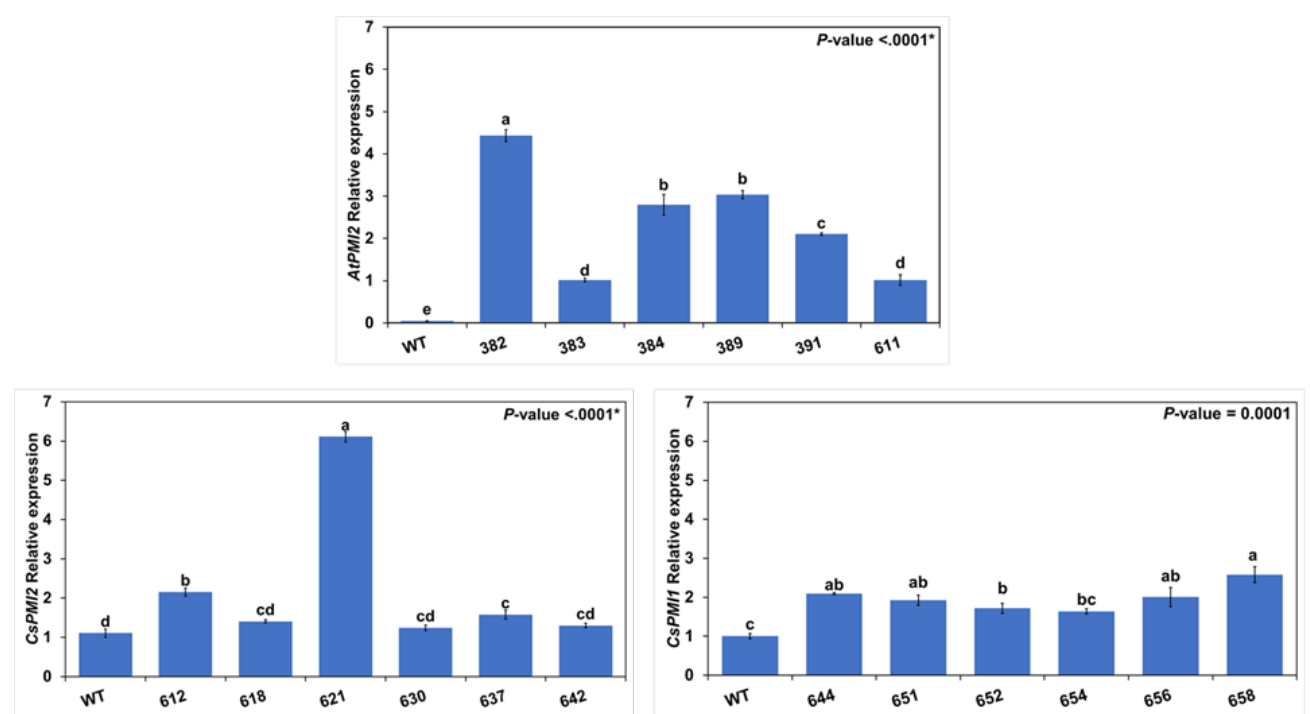
Figure 4. Quantitative real-time RT-PCR analysis of phosphomannose isomerase gene ( PMI) expression in citrus leaves. The citrus actin7 gene (NCBI accession: XM_006464503.3) was used as a reference gene for the normalization. WT, non-transgenic mature Kuharske. Upper: lines 382, 383, 384, 389, 391, 611 are the AtPMI2 transgenic lines. Lower left: lines 612, 618, 621, 630, 637, 642 are the CsPMI2 transgenic lines. Lower right: lines 644, 651, 652, 654, 656, 658 are the CsPMI1 transgenic lines; six independent transgenic lines of mature Kuharske were selected randomly and examined from each construct, three replicates from each plant. The test was repeated twice. Bars represented the Mean ± Standard Error (SE) of three technical replicates. Means followed by the same letter were not different at p ≤ 0.05 using Student’s t -test.